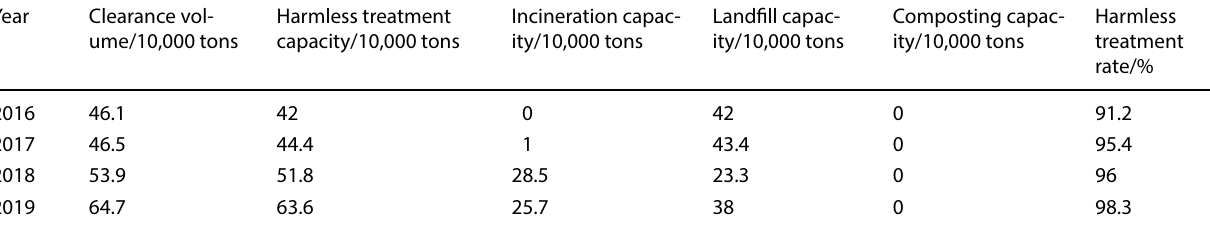
Table 2 Urban domestic waste removal and treatment in Tibet from 2016 to 2019